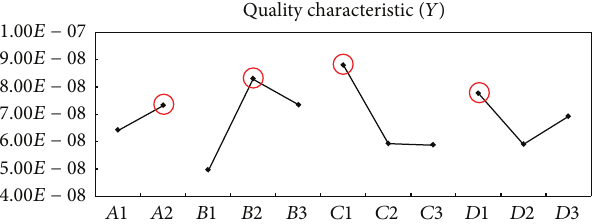
Figure 4: The factor effects response plot in 𝑌 -direction.